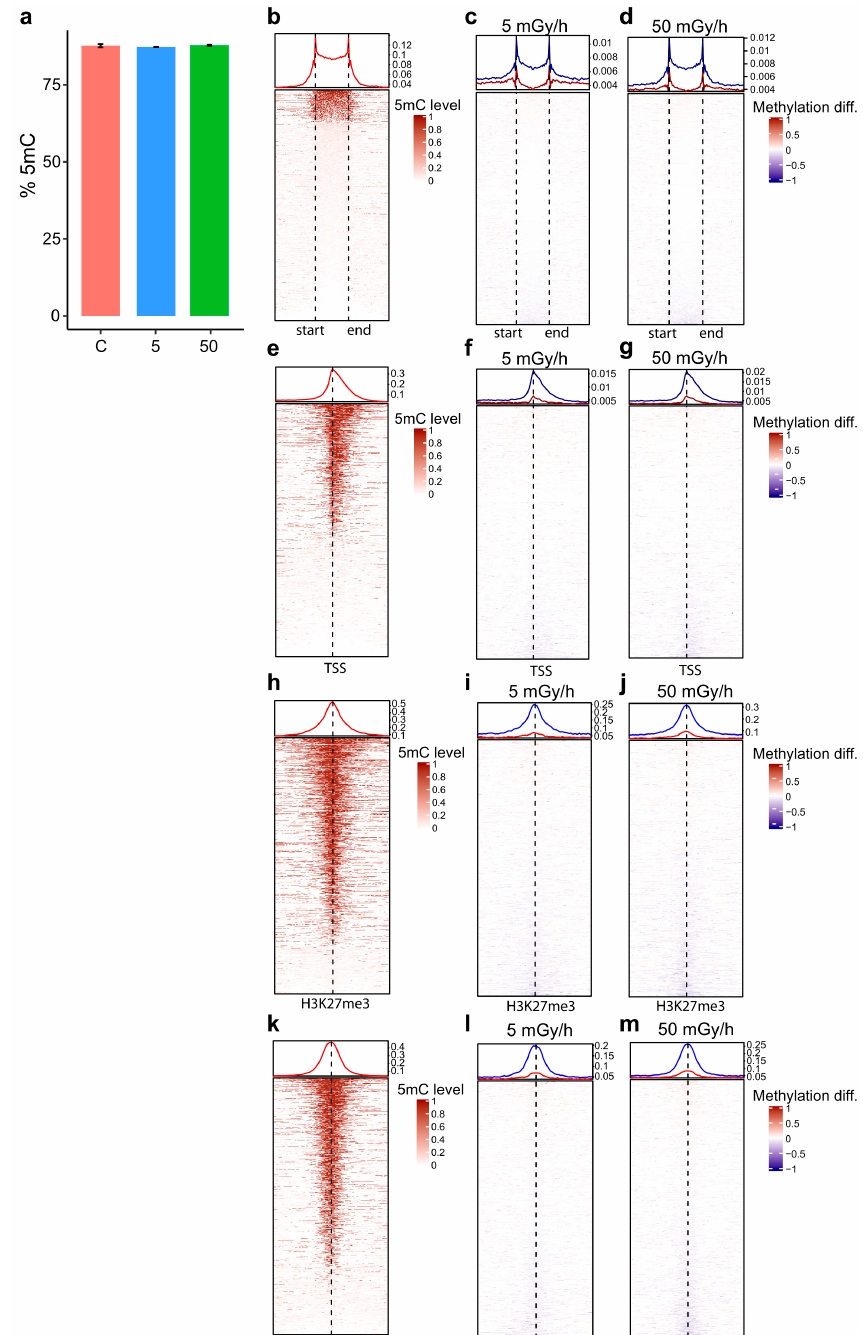
Figure 3. Analysis of 5mC abundancy in the CpG context after exposure to IR at 5 and 50 mGy / h in shield embryos. ( a ) Mean percentage of 5mC in control (C, red), 50 mGy / h (50, green) and 5 mGy / h (5, blue). Standard errors for the biological replicates are indicated. ( b – m ) Dot plots of 5mC mapped in a window 2 kb up and down to known genomic features. Start–end of CpG islands (CGIs) as well as localisation of transcriptional start (TSS) or the histone marks H3K27me3 and H3K4me3 are indicated by the dashed lines. The fraction of 5mC in the +/ − 2 kb genomic window is indicated at the top of each dot plot. ( b ) Fraction of 5mC in control embryos in CGIs, ( e ) in TSS, ( h ) in H3K27me3 and ( k ) in H3K4me3. Fraction of di ff erentially methylated cytosine (5mC) in exposed embryos (5 and 50 mGy / h) in ( c , d ) CGIs, ( f , g ) TSS, ( i , j ) H3K27me3 and ( l , m ) H3K4me3. Blue: hypomethylated compared to control and red: